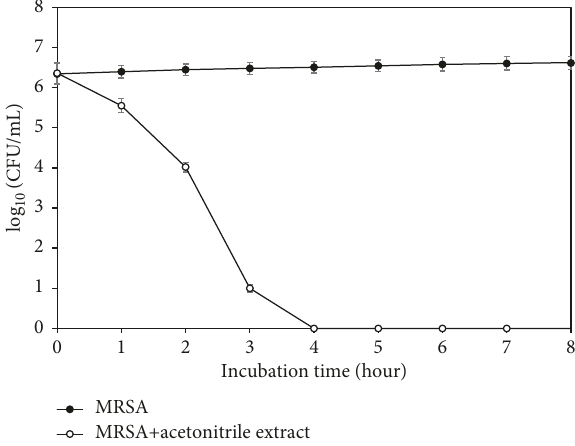
Figure 2: Time-killing curve of the acetonitrile extract of A lakoocha roxb against